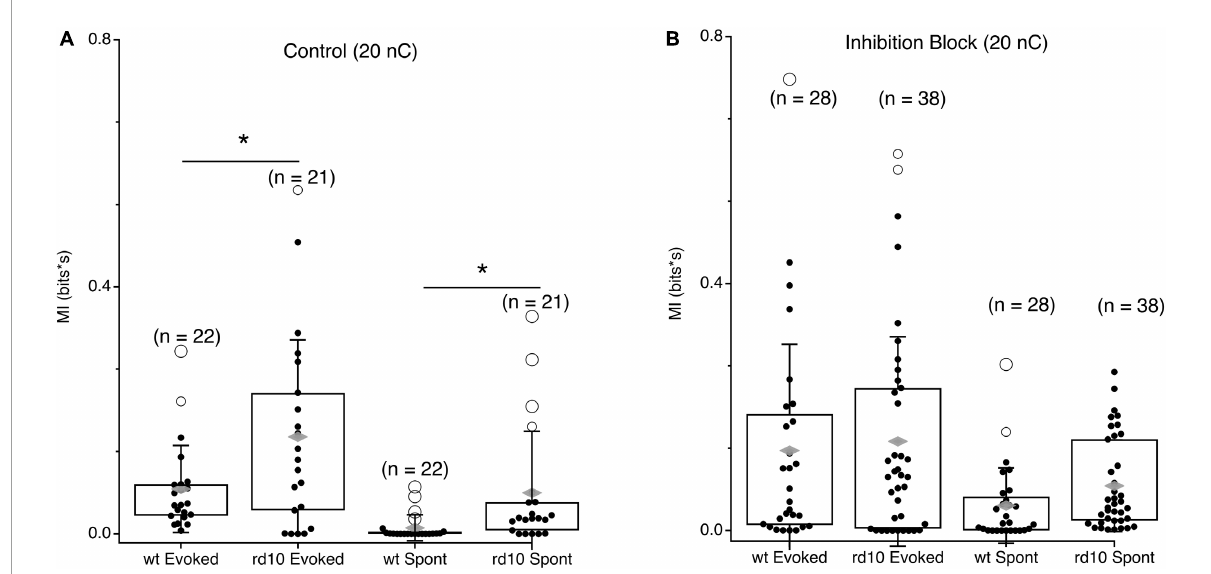
FIGURE5 Comparison of evoked and spontaneous MI between wt and rd10 RGC pairs. (A) Box plots showing integrated MI between RGC pairs in wt and rd10 retina for evoked and spontaneous time periods. (B) Same as panel (A) , but in inhibition block (5 µ M SR-95531, 50 µ M TPMPA, and 5 µ M strychnine). Filled black circles represent data points, open circles represent outliers, whiskers show 1 standard deviation, gray diamonds represent the mean. *Denotes p < 0.05.